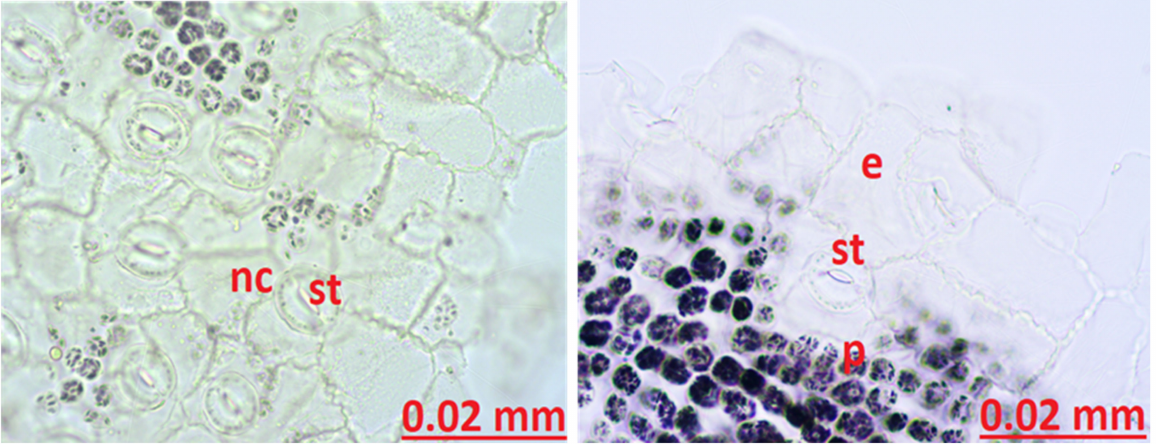
Figure 3. The leaf lower superficial anatomy of Hypericum scabrum ; e: epidermis, p: parenchyma, nc: neighboring cells, st: stomata.